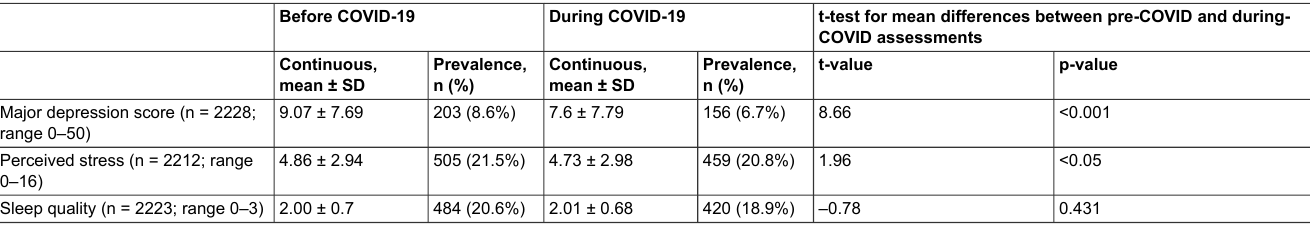
Table 2: Descriptive statistics of the psychological consequences of COVID-19 without mention of it as a cause, measured before and during COVID-19. Before COVID-19 During COVID-19 t-test for mean differences between pre-COVID and during- COVID